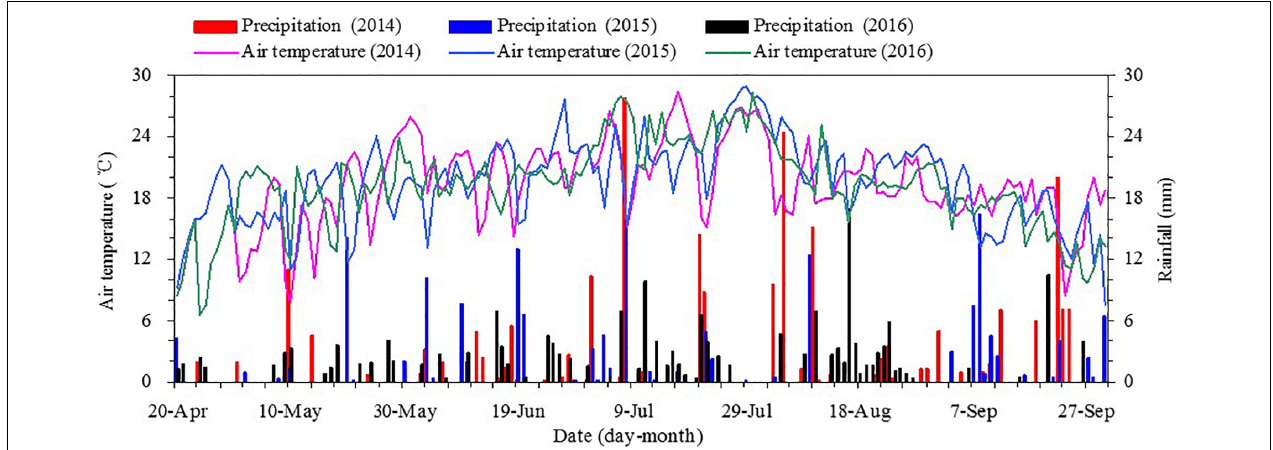
FIGURE 1 | Daily mean air temperature and total precipitation during the growing season from 2014 to 2016 at the Wuwei Experimental Station in northwestern China.